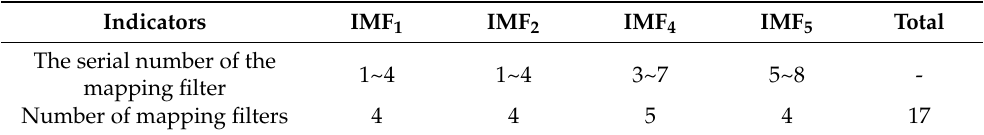
Figure 9. Mapping relationship between IMF and Mel filter: ( a ) IMF 1 ; ( b ) IMF 2 ; ( c ) IMF 4 ; ( d ) IMF 5 . Table 6. Mapping relationship between each IMF component and Mel filter.